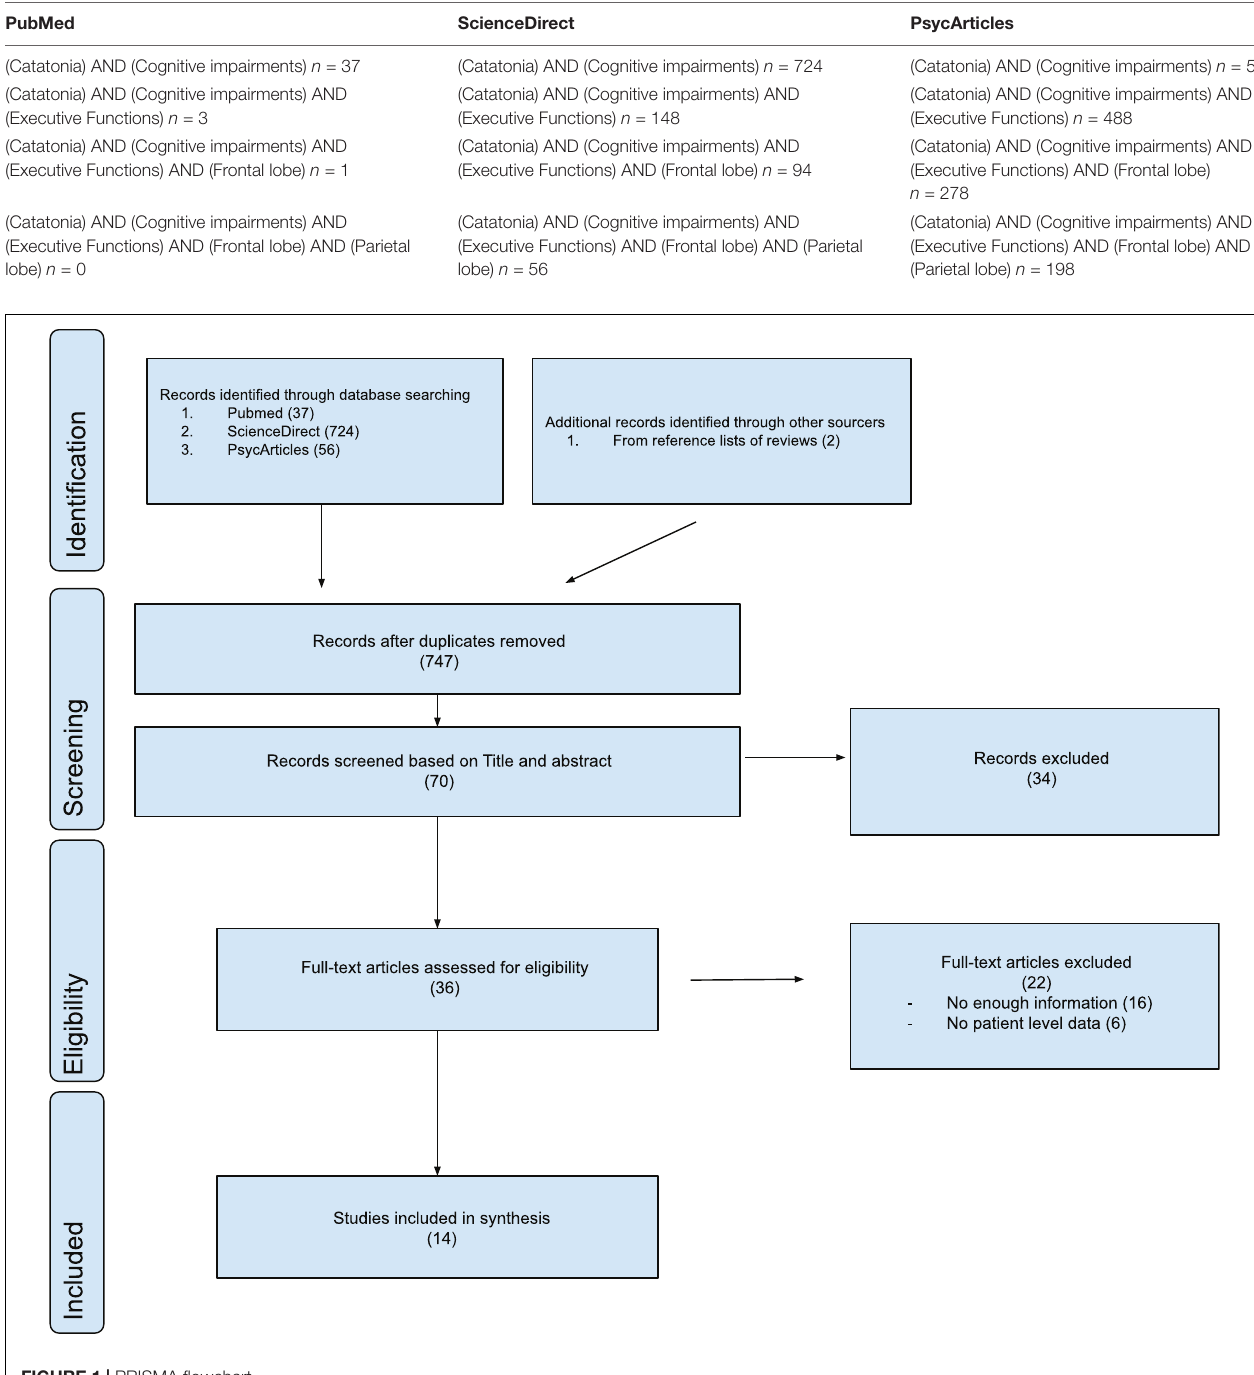
TABLE 1 | Search strategy.